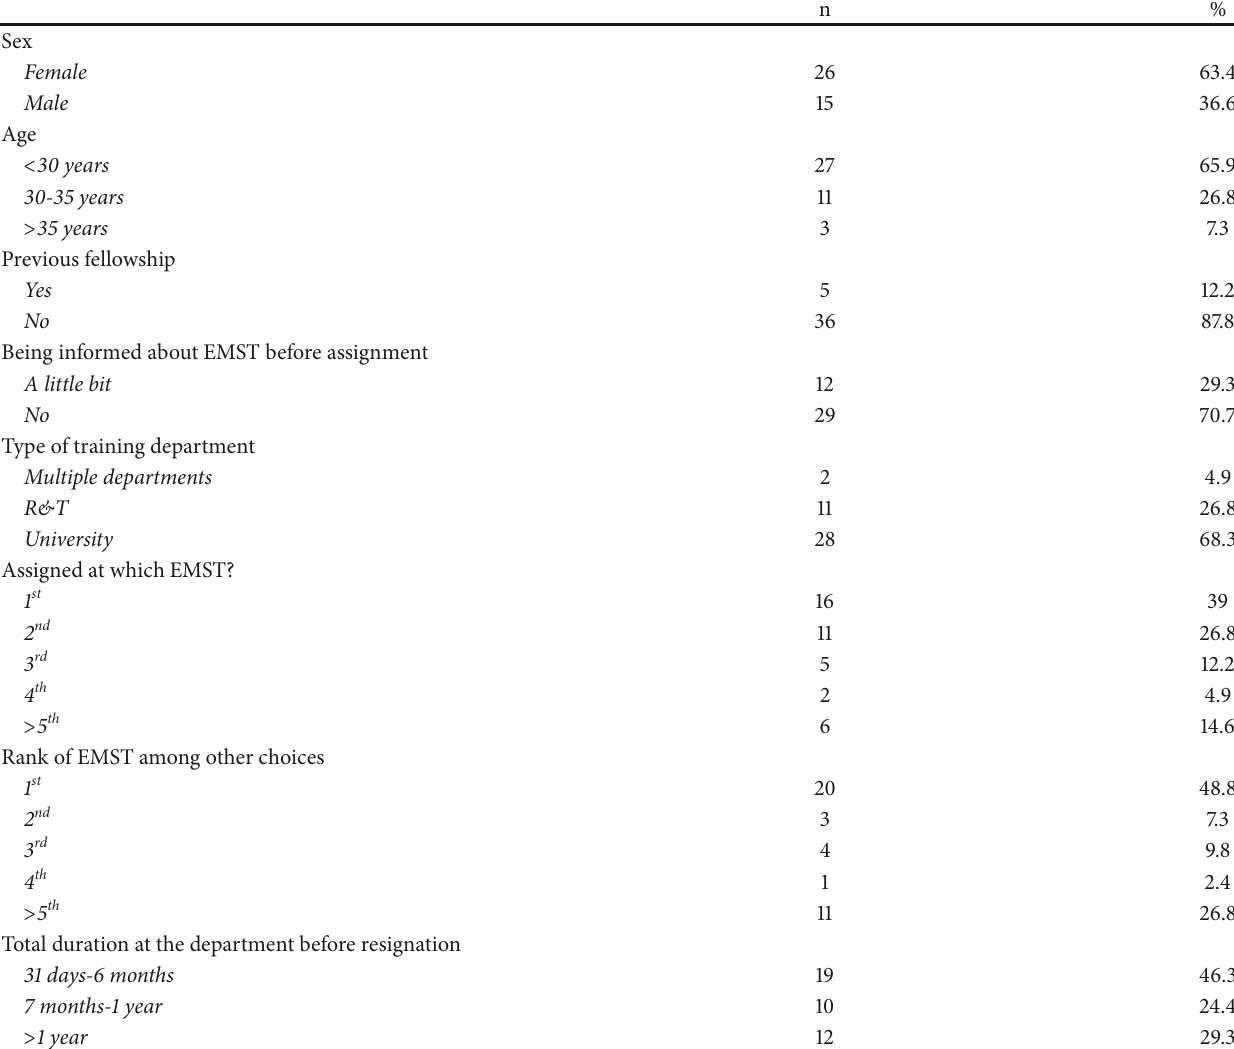
Table 1: General characteristic of the participants and their assignment to